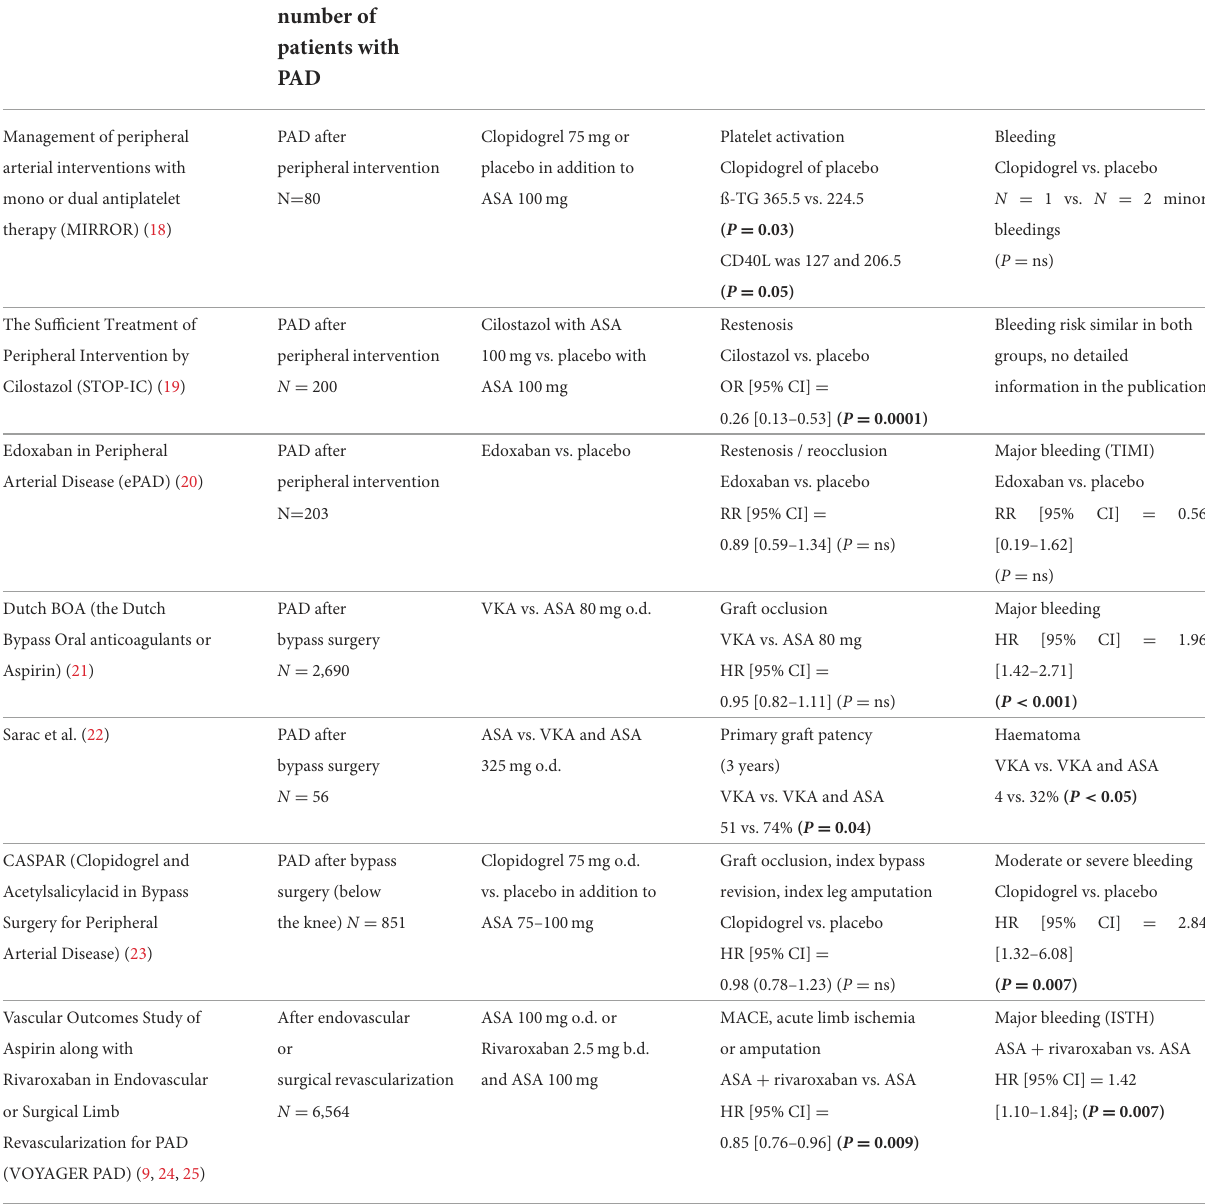
TABLE 1B Studies on antithrombotic therapy in patients after peripheral